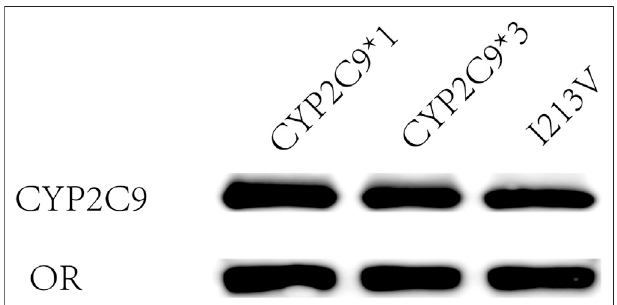
FIGURE 2 | Expression of CYP2C9 alleles in Sf 21 insect cells. The externally expressed oxidoreductase (OR) and cytochrome P450 2C9 (CYP2C9) proteins were identi fi ed by western blotting with antibodies against OR and CYP2C9,